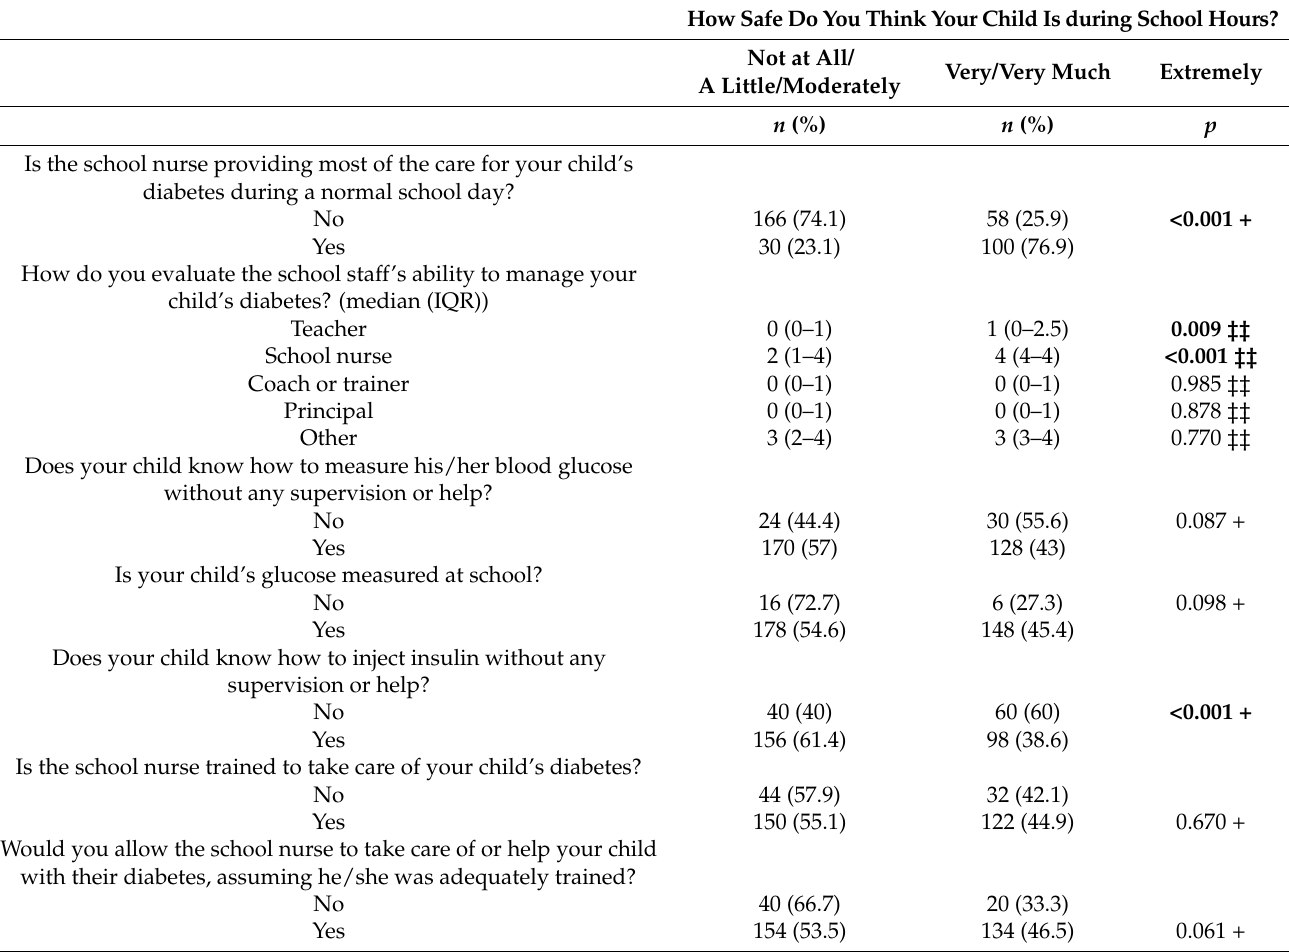
Table 4. Association of participants’ feeling safe for their child during school hours with information regarding management of their child’s